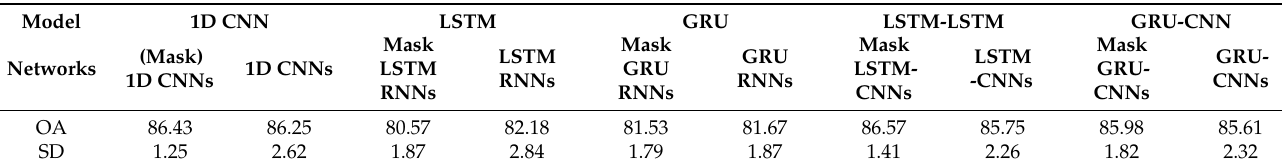
Table 3. Average overall accuracies and standard deviations (over five different random splits) of five deep learning models using Sentinel-2 TSD with missing information and filled Sentinel-2 TSD. SD, standard deviation.